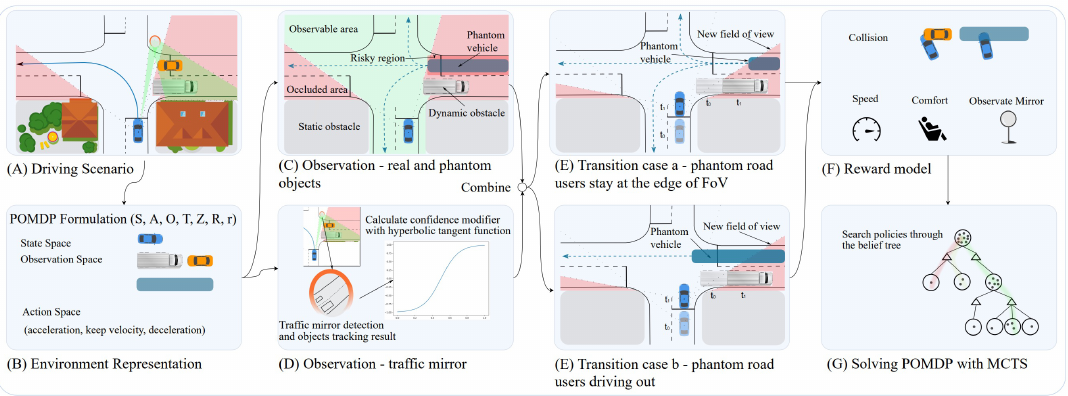
Figure 5. A framework of traffic mirror-aware POMDP behavior